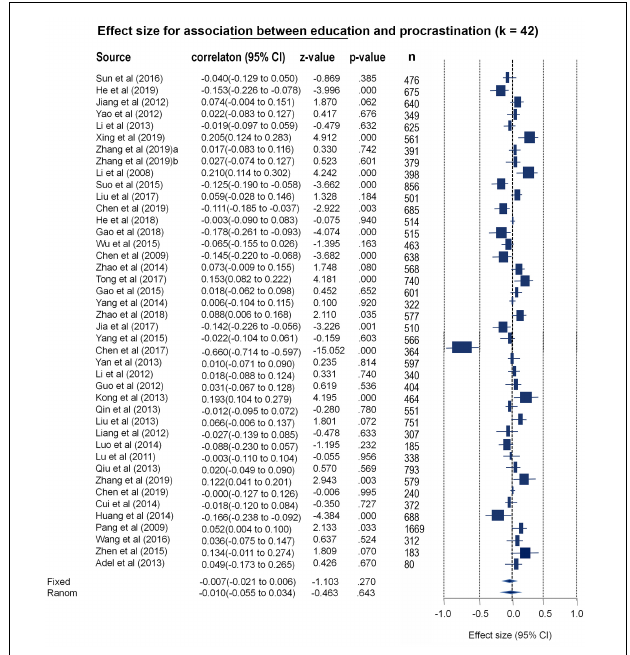
FIGURE 6 | Forest plot for the meta-analytic results toward educational background differences of